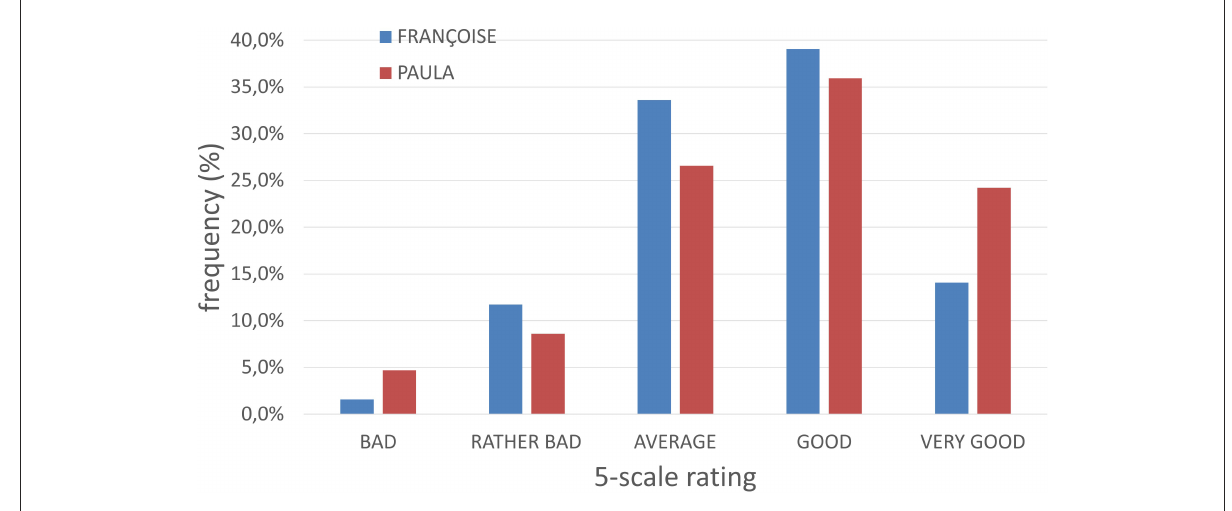
FIGURE8 Frequency distribution (%) of rankings for all movement parameters (bar plot).